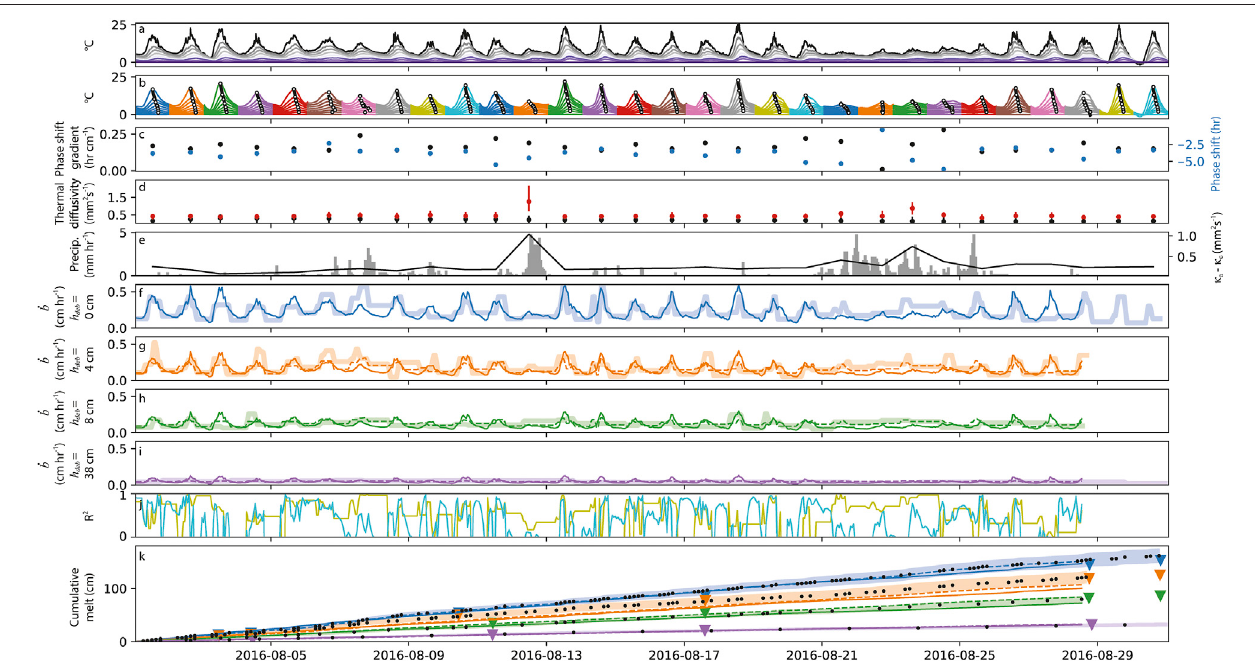
FIGURE 6 | Time-series showing data and model results at locations (1) – (5) in Figure 1 . (A) raw temperature pro fi le data where each line is a temperature record from within the debris cover (4 cm spacing). Black is the surface and dark purple is the debris-ice interface. (B) same as (A) but smoothed to automate the selection of diurnal maxima and amplitude values. The series is segmented per day (colors). The phase shift gradient is shown: white dots are diurnal maxima and the black line is a leastsquareslinear fi tofthesepoints.Thesegradientsareplottedintemperatureovertimespace,butduetothelinearspacingofthesensors,isproportionaltothe time over debris depth gradient (C) (black dots). Blue dots in (C) are the maximum phase shift in hours between the top surface layer and the bottom of the debris layer. Both values in (C) are computed for each day. (D) median (dot) and 33 – 66 percentile range (bar) of apparent thermal diffusivities calculated for each day from two methods:diurnalamplitudes( κ a ,red)and theBiot-Fourier diffusionequationconsideringonly conductive heattransfer ( κ c ,black). (E) localprecipitationrate(greyvertical bars) measured atlocation(8)in Figure1 . Theblack linescaled bythesecond y -axis isthedifference between κ a and κ c . (F – I) ablation modeledfrom Eq.13 (this study) solidlines;andfrom Eq.14 (Rounceetal.,2021)dashedlines.Measuredmeltiswidetransparent.Colorsarethesameas Figures3 – 5 :blue,bareglaciericeat Figure1 location (5); orange, 4 cm debris thickness (4); green, 8 cm debris thickness (2); and purple, 38 cm debris thickness (1). (J) R 2 between the measured and modeled Østrem curve for each time step; turquoise, this study; yellow-green, Rounce et al. (2021). The model following Rounce et al. (2021) was forced with measured bare ice melt and is therefore omitted from (F) and not included in the R 2 calculation (J) . (K) cumulative melt. Sel fi e stick sub-daily measurements are shown as black dots. Error bounds around measured melt are colored, transparent; and traditional, manual ablation stake measurements are shown as colored triangles. Model results are shown as a solid line (this study), and dashed (Rounce et al., 2021). All colors in (K) match (F – I) .